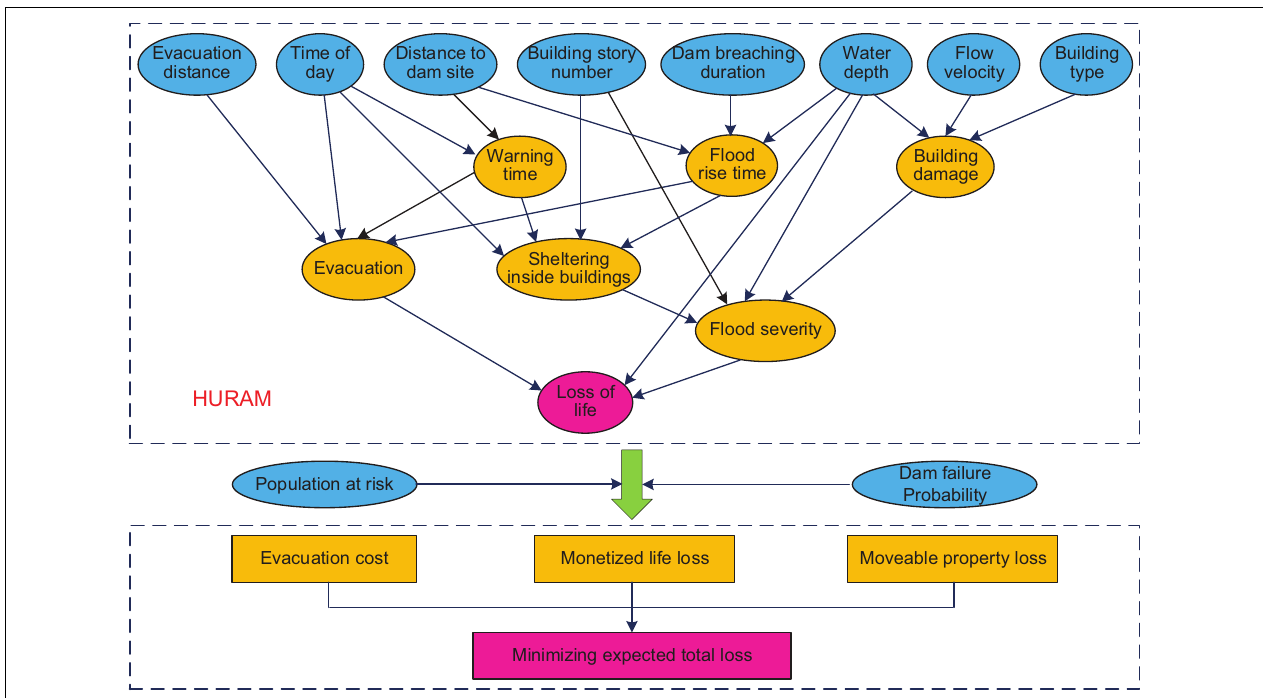
FIGURE 1 | The logic structure of the DYDEM model modified from Peng and Zhang (2012a, 2013a). HURAM provides the evacuation rate and fatality ratio to calculate the evacuation cost, monetized life loss, and moveable properties loss. Note that the unmovable property loss that cannot be rescued by warning and evacuation is not considered in this